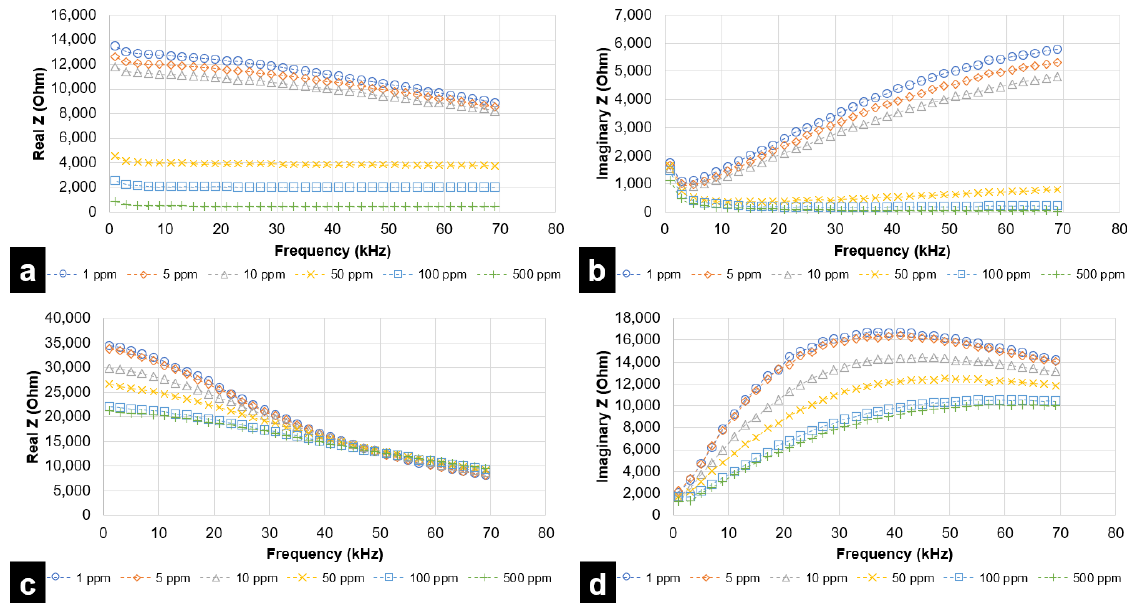
Figure 10. EIS analysis for GMP (umami) and sucrose (sweet), in the range of 1 kHz to 69 kHz, for DLW-photolithography- based IDE sensor in terms of ( a ) Resistive Impedance vs. Frequency (GMP) ( b ) Reactive Impedance vs. Frequency (GMP) ( c ) Resistive Impedance vs. Frequency (sucrose) ( d ) Reactive Impedance vs. Frequency (sucrose).